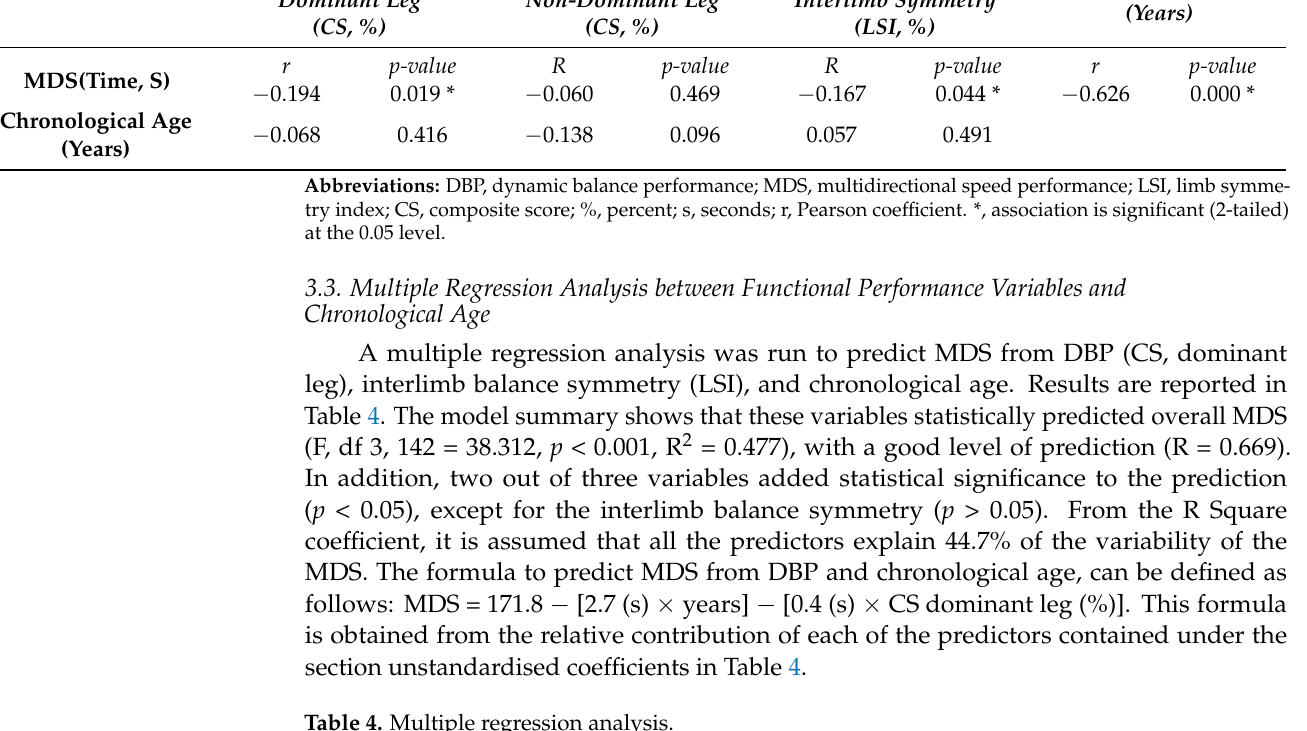
Table 4. Multiple regression